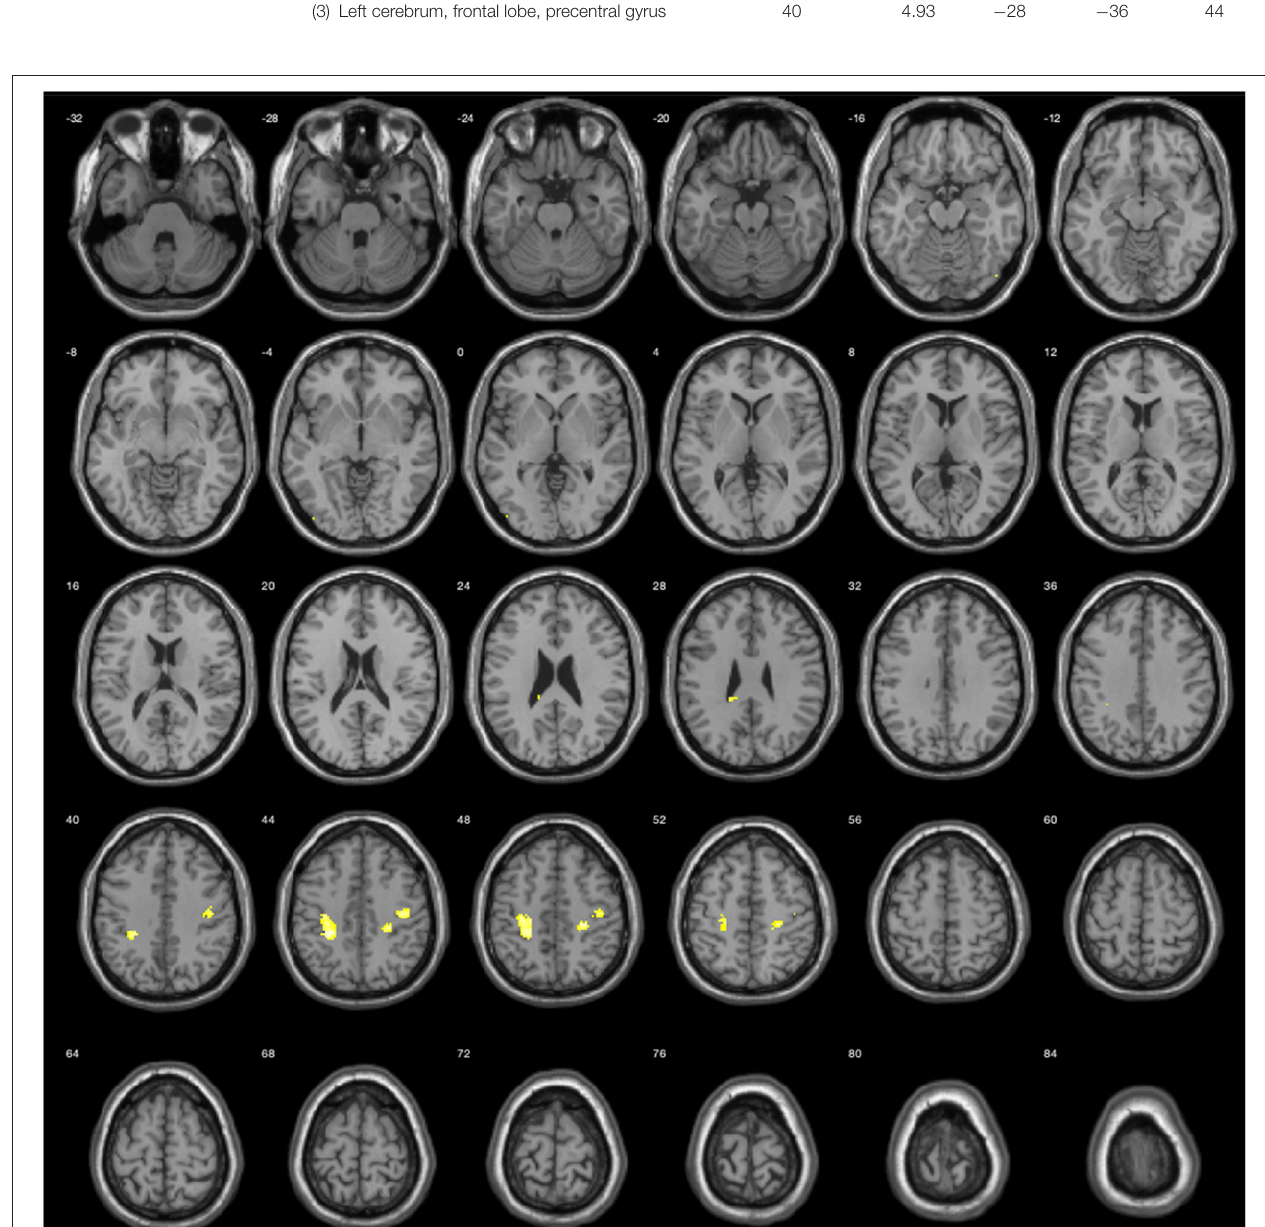
Hyperopic defocus vs. clear focus